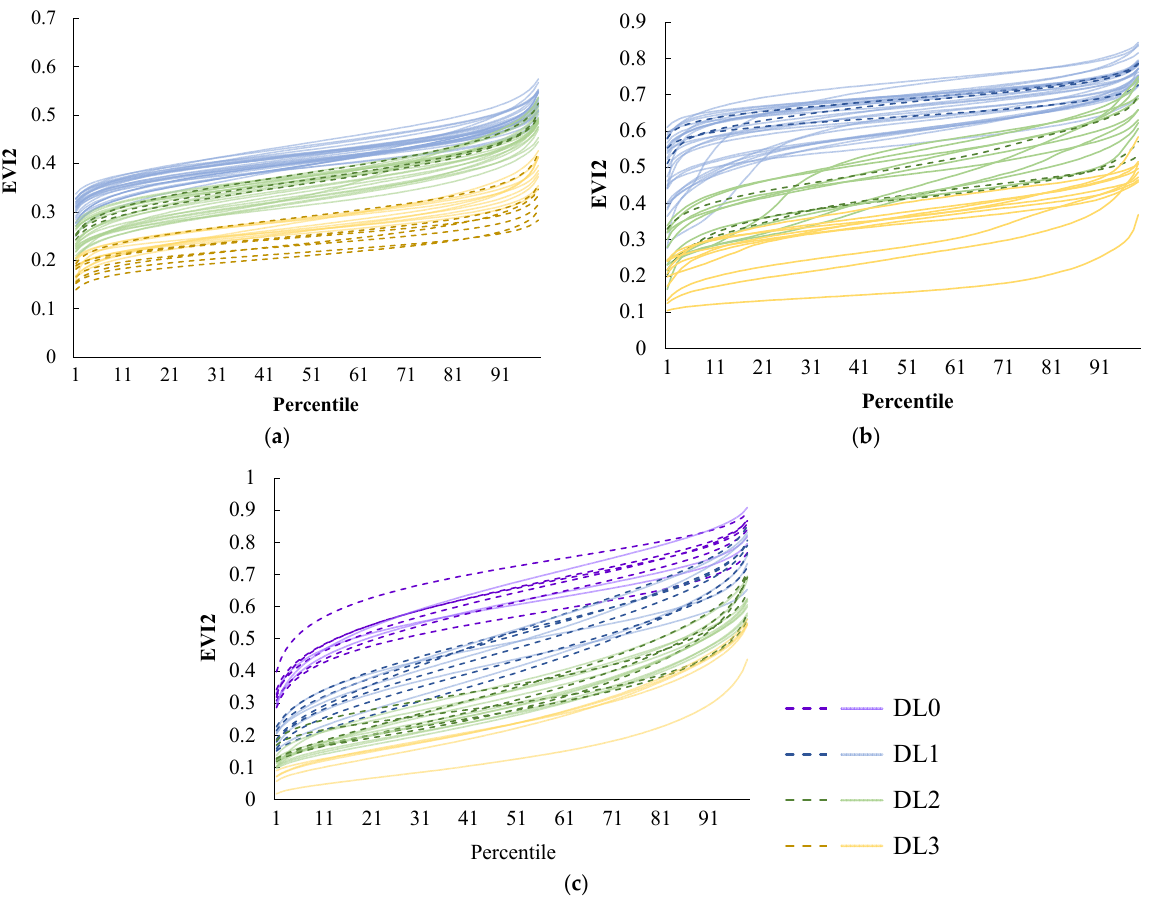
Figure 6. EVI2 of 1–99 percentiles for each field: ( a ) Karangwangi (the first survey); ( b ) Sukajaya (the second survey); ( c ) Jati (the third survey). Different colored lines indicate different DLs classified by method2 (k-means clustering). Dotted lines indicate assessed fields by POs with the colors of classified DLs.